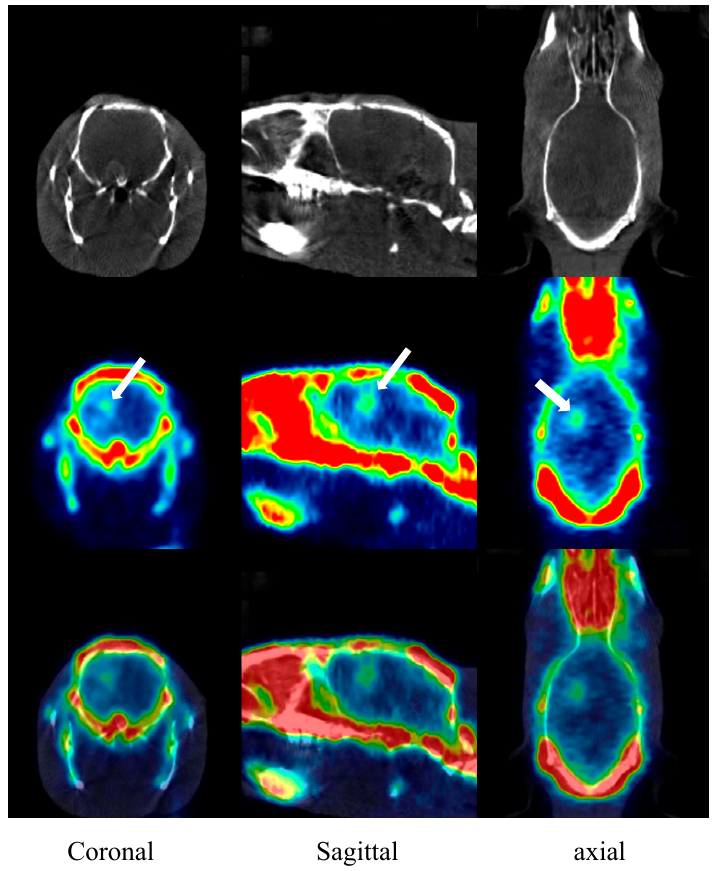
Figure 8. A static PET/CT image collected over a period of 0 to 60 min of [ 18 F]FOFA {[[ 18 F]F- 1 } in the C6 glioma-bearing rat with an injection dose of 2.81 mCi/1 mL of [ 18 F]FOFA{[ 18 F]F- 1 }. Organs scanned are shown for the head part. The first row shows CT images; the second row shows PET images; the third shows their overlay.